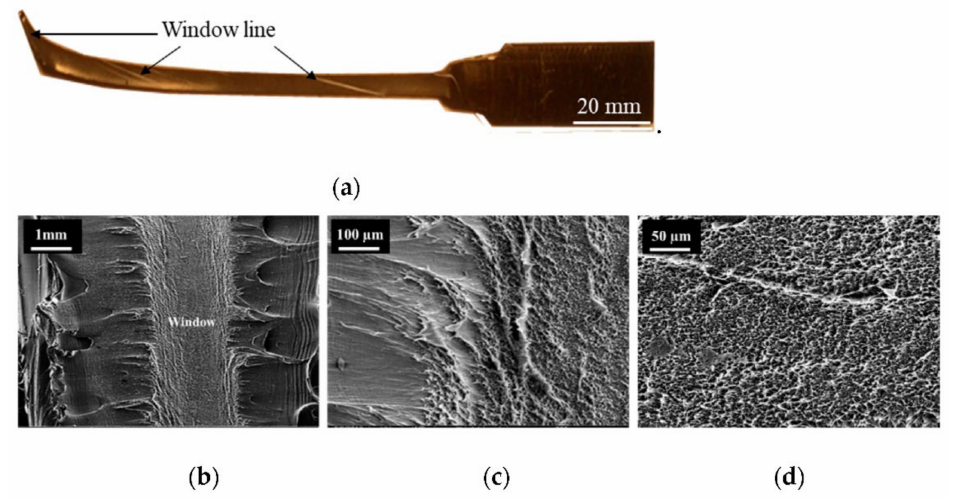
Figure 17. ( a ) Twisted window line along the cold drawn length of the tensile specimen and fracture surface morphology at ( b ) × 40, ( c ) × 200, and ( d ) ×